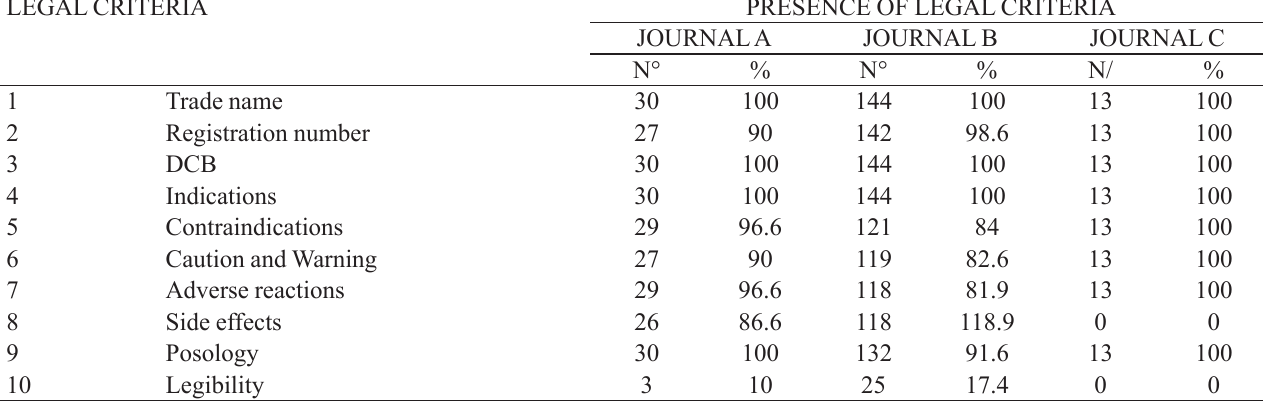
TABLE II – Evaluation of legal criteria per journal LEGAL